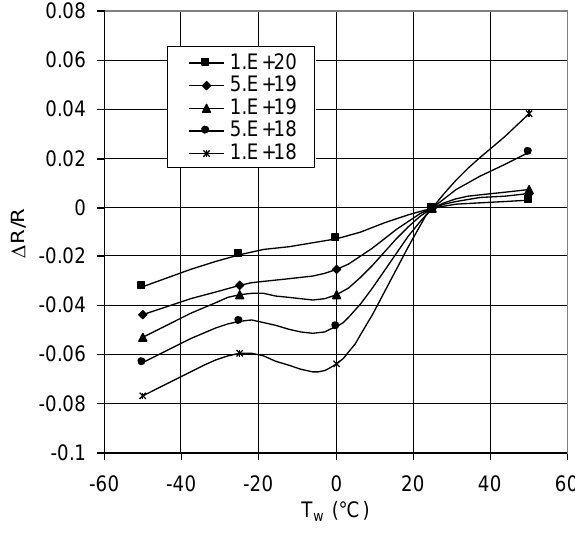
Figure 17. Temperature response of the sensing unit at stress-free condition for different doping concentrations to evaluate the sensor TCR.